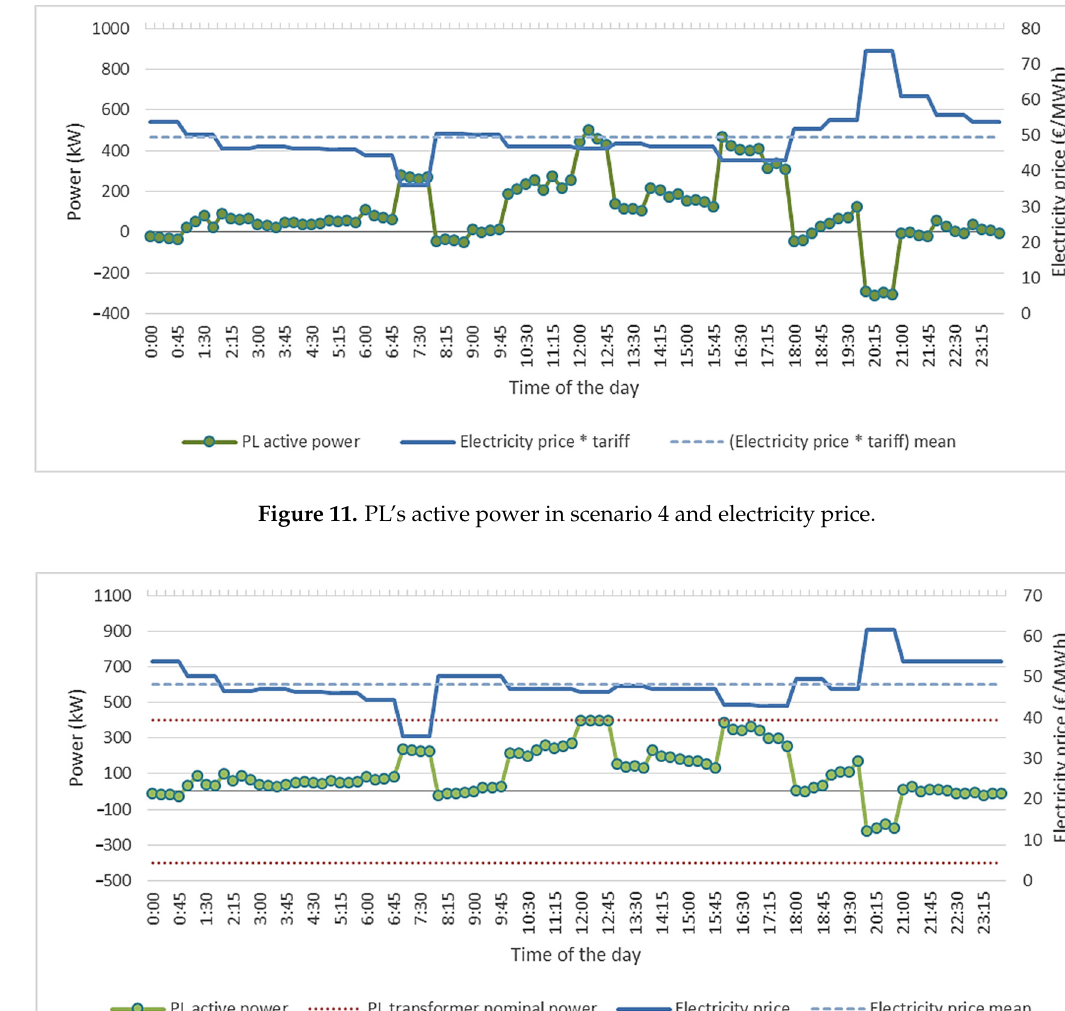
Figure 10. PL’s active power in scenario 3 and electricity price.